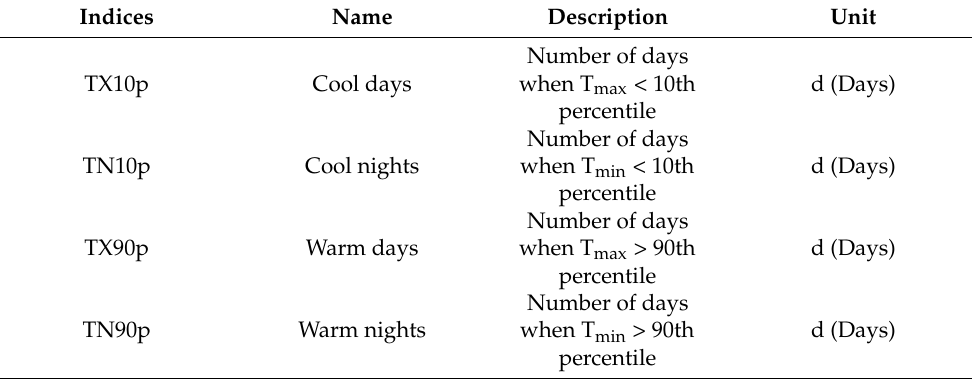
Table 2. Extreme temperature indices selected for this study, with the indicator names, definitions, and